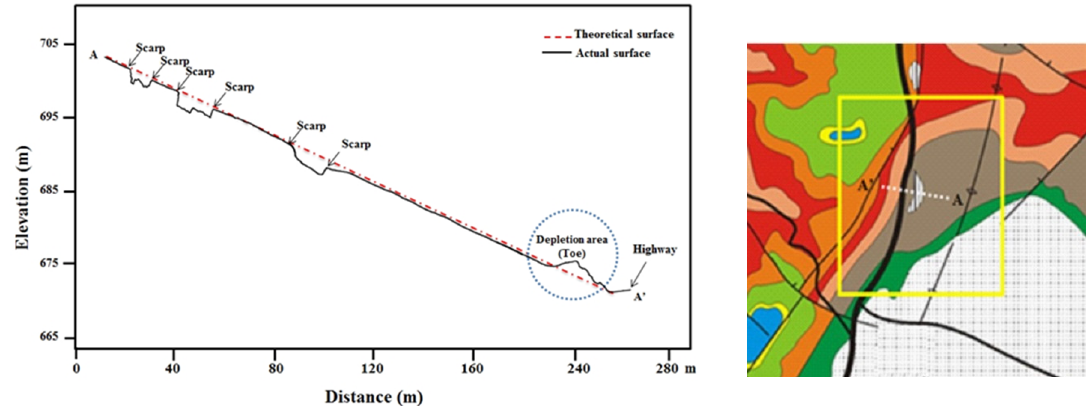
Figure 13. Cross-section (left image) along the profile A-A ′ (right image is a subset of the geological map) of the landslide in the central part of the study area.